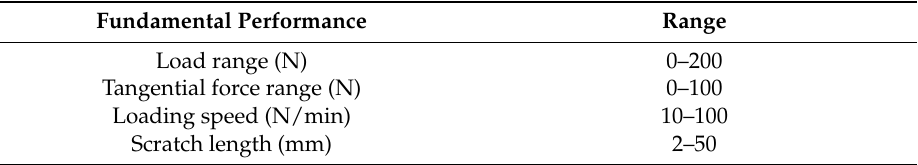
Table 2. The mechanical properties of Oxygen ‐ Free Copper (OFC) stainless steel.